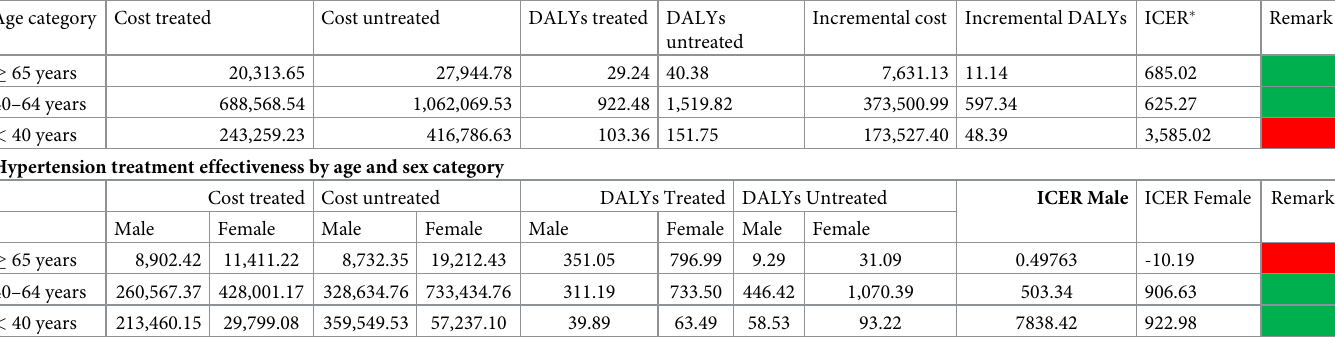
Table 4. Projected average annual incremental results of treating adults with untreated hypertension between the ages of 33 and 64 years (2020–2030). Age category Cost